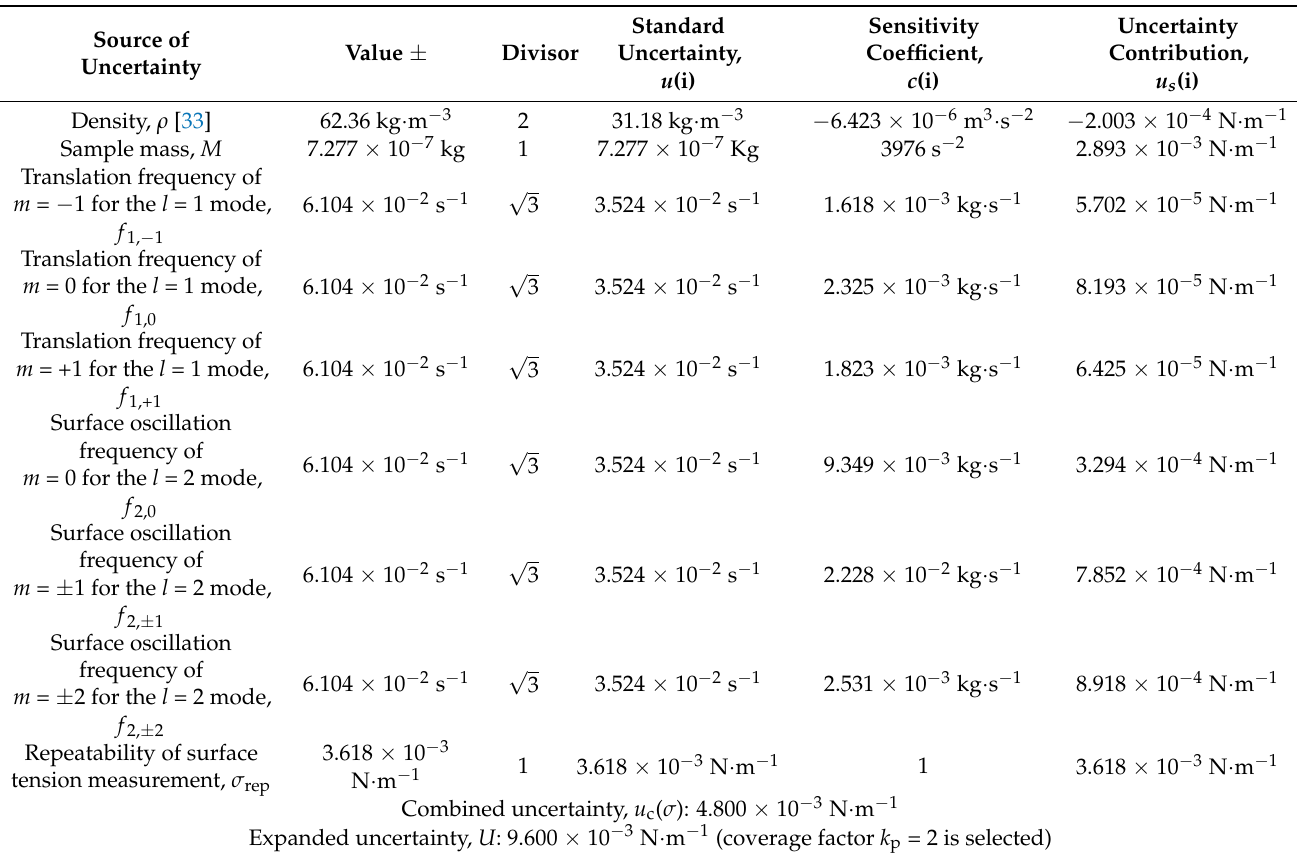
Table 3. Uncertainty budget of surface tension measurements of liquid titanium by EML when the calculation result of uncertainty for the measurement plot showed the largest